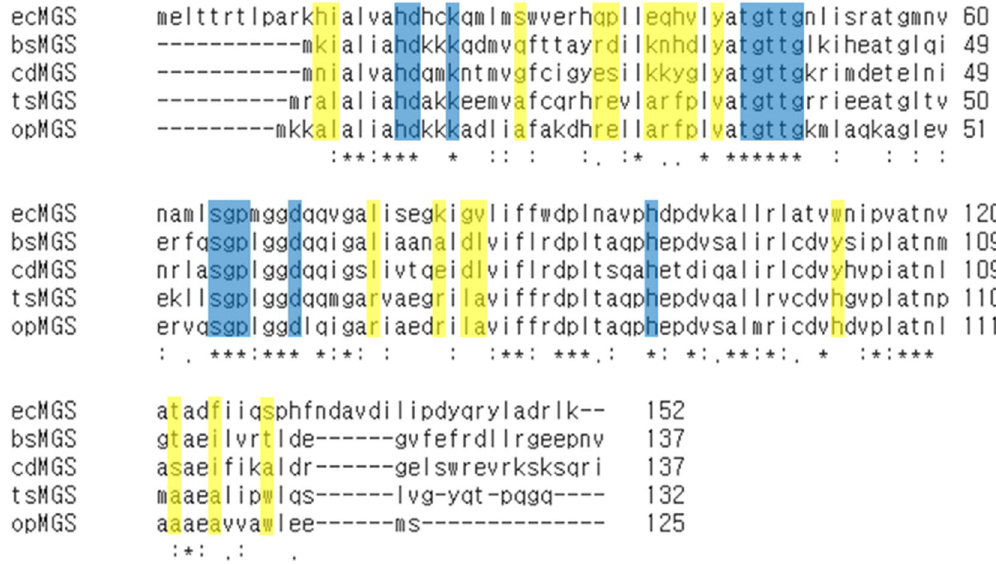
Figure 4. Amino acid sequence alignment of cdMGS and opMGS with ecMGS ( E. coli ), bsMGS ( B. subtilis ) and tsMGS ( Thermus sp . GH5). The ecMGS, bsMGS and cdMGS represent mesophilic MGSs, and tsMGS and opMGS represent thermophilic MGSs. Blue-shades indicate the active site. Yellow-shades indicate residues that are found common in the thermophilic MGSs but different from the mesophilic enzymes. Asterisk, colon and full stop indicate the degree of sequential similarity from the highest to the